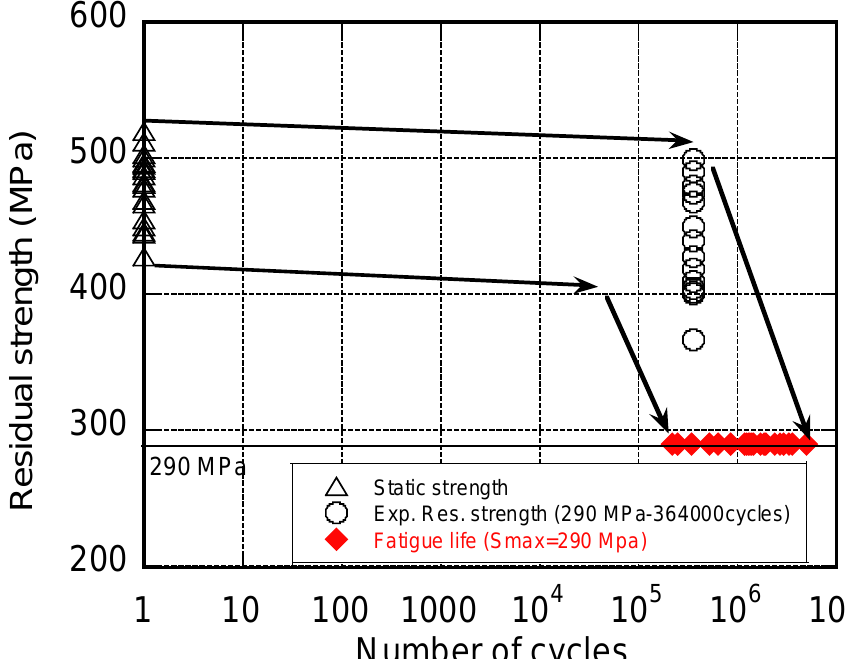
Figure 4. Phenomenological upper and lower bounds of the residual strength evolution. The arrows are guides for the eyes. Experimental residual strengths were measured after 364.000 cycles at σ max = 290 MPa, and stress ratio R = 0. Experimental data re-elaborated from Ref. [6].